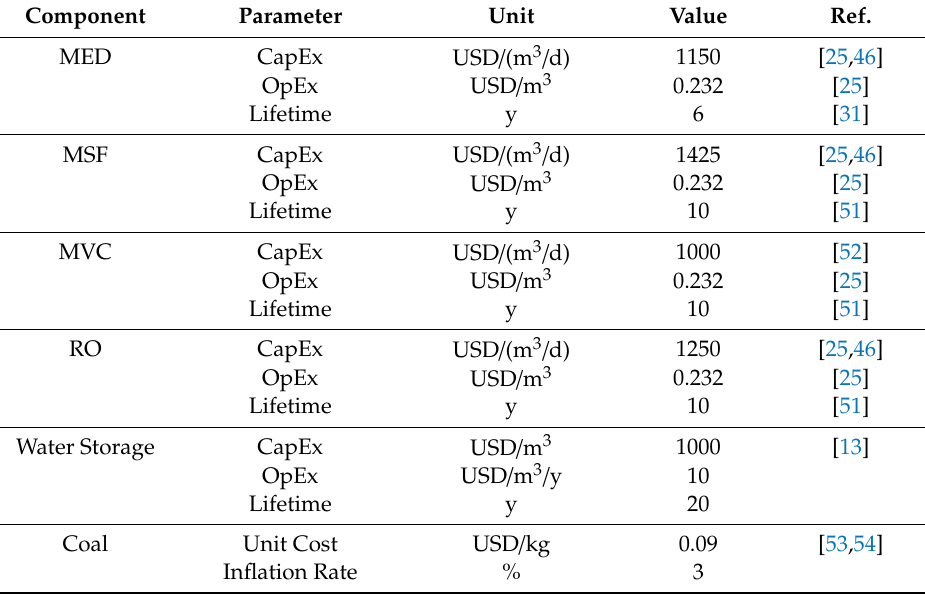
Table 4. Techno-economic parameters of desalination technologies.